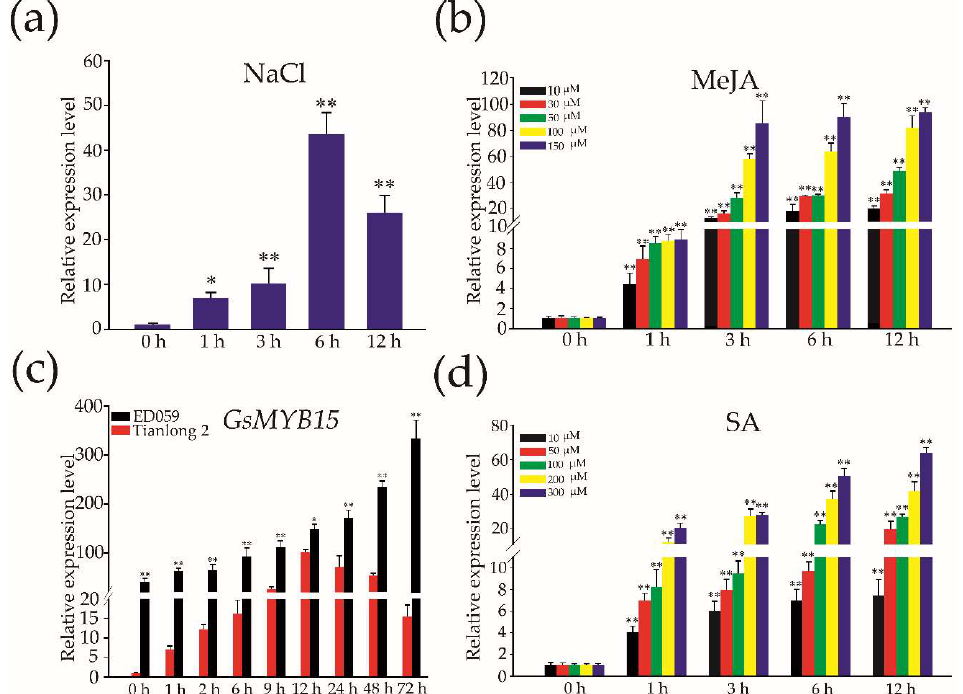
Figure 3. Expression patterns of GsMYB15 in soybean in response to NaCl ( a ), MeJA ( b ), SA treatments ( c ) and H. armigera larvae ( d ). Plants were collected at the indicated time points. GsSKIP16 was used as the internal reference control to normalize the templates. The relative mRNA levels are represented as the mean ± SD ( n = 3). Statistically significant differences were assessed using Student’s t -test (* p < 0.05, ** p < 0.01).